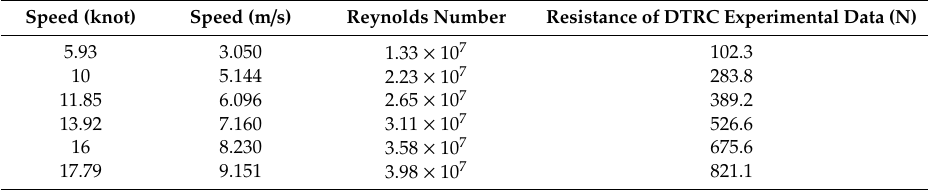
Table 3. Experimental conditions for resistance